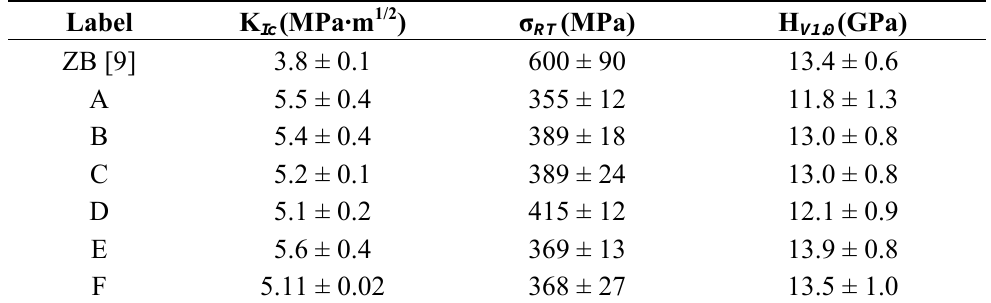
Table 3. Mechanical properties: fracture toughness (K ). Mean ± 1 standard deviation. microhardness (H V1.0